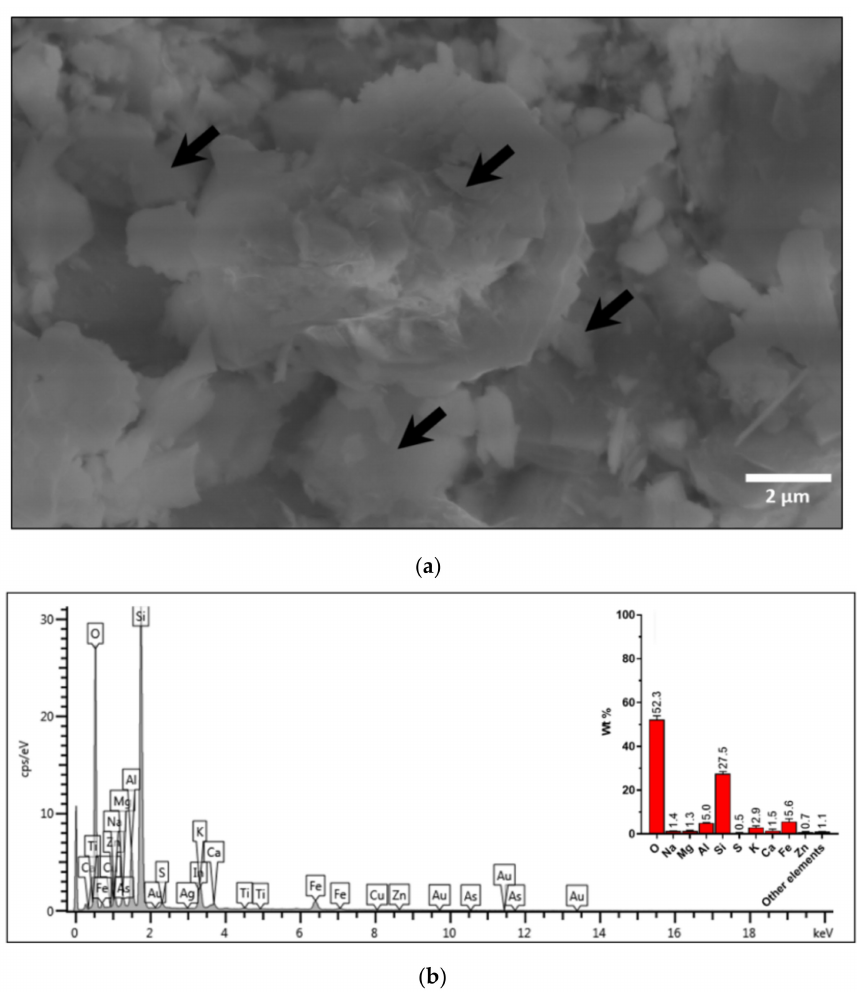
Figure 2. ( a ) Scanning electron micrographs of paste-tailing samples, carbon was used as a surface coating (arrows show the different sizes of tailings particles). ( b ) Energy-dispersive X-ray spectrum of paste-tailing samples. Intensity of Al, Si, Fe, S, and Zn emission lines are shown in the Energy Dispersive X-Ray Spectroscopy (EDX) spectrum. The images and EDX spectrum were obtained from a representative sample of the M2 site. Scale bar indicates 2 µ